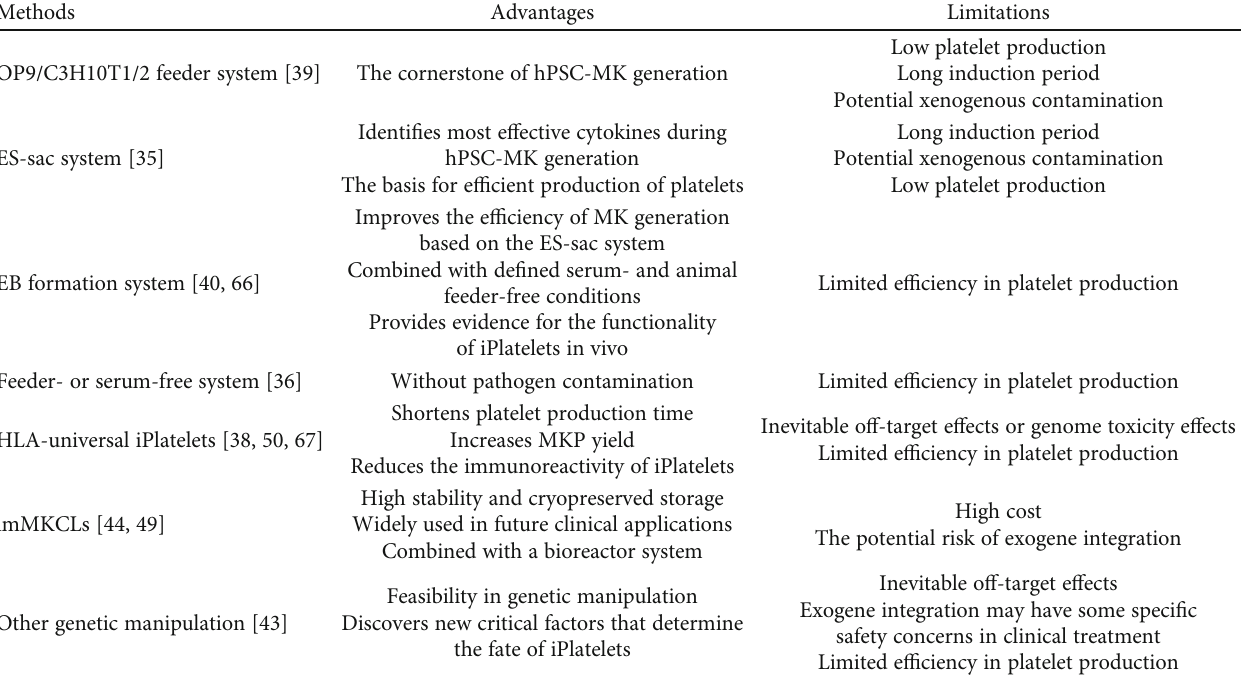
Table 2: Advantages and limitations of current approaches for iPlatelet